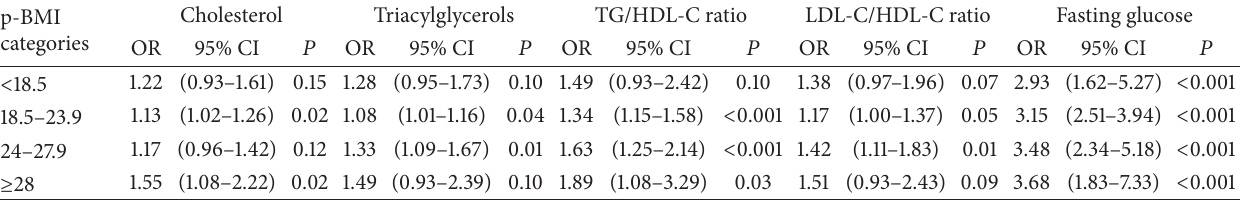
p-BMI: prepregnancy body mass index; TG/HDL-C: triglyceride to high-density lipoprotein cholesterol ratio; LDL-C/HDL-C: low-density lipoprotein cholesterol/high-density lipoprotein cholesterol